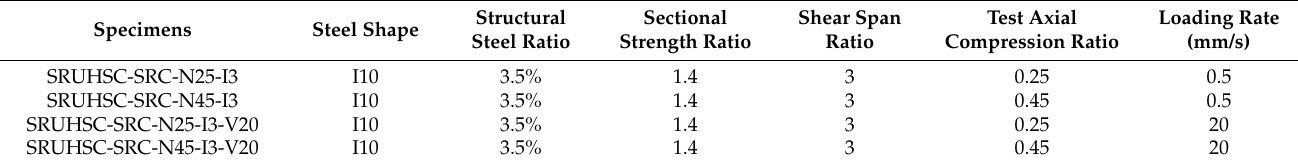
Table 1. Design parameters of the specimens.